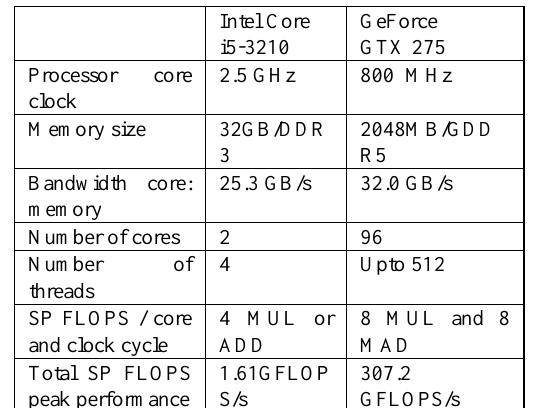
Table 1. Technical Specification